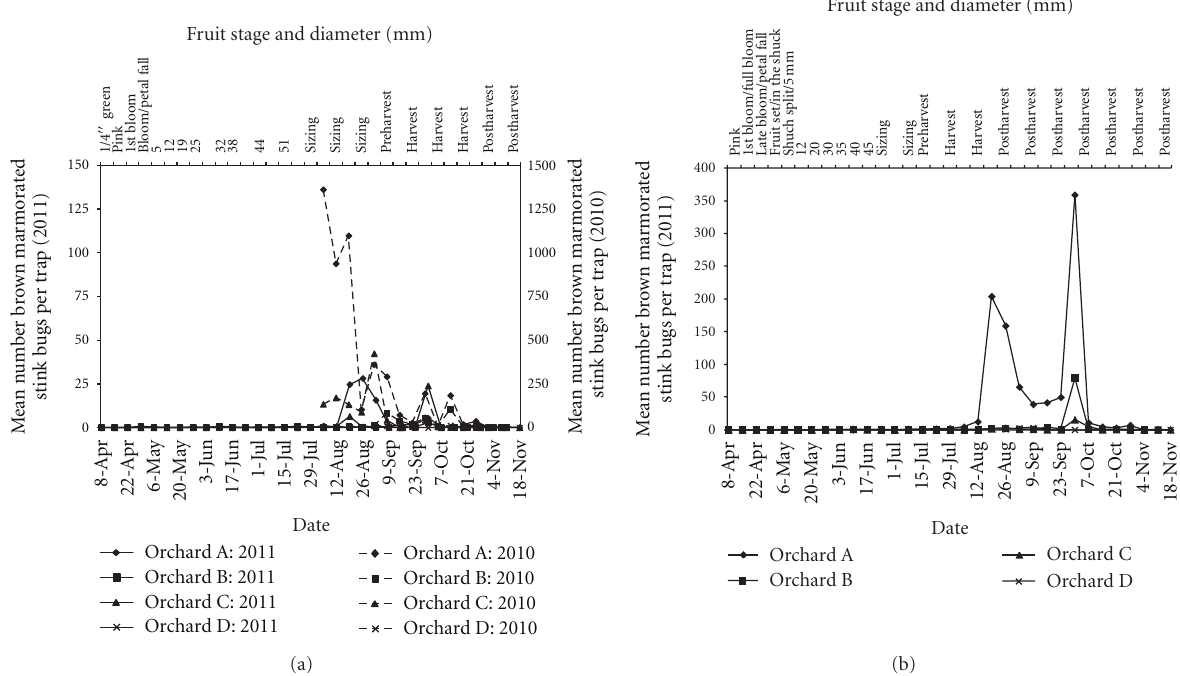
Figure 5: Mean number of brown marmrorated stink bug adults and nymphs captured per trap at orchards A-D in (a) apple in 2010 and 2011 and (b) peach plots in 2011. Table 2: Total number of targeted brown marmorated stink bug insecticide applications, mean interval (d) ± SEM between insecticide applications, and mean A.I.M. score ± SEM and total A.I.M. score in peach plots from 2010 to 2011 at four commercial orchards.